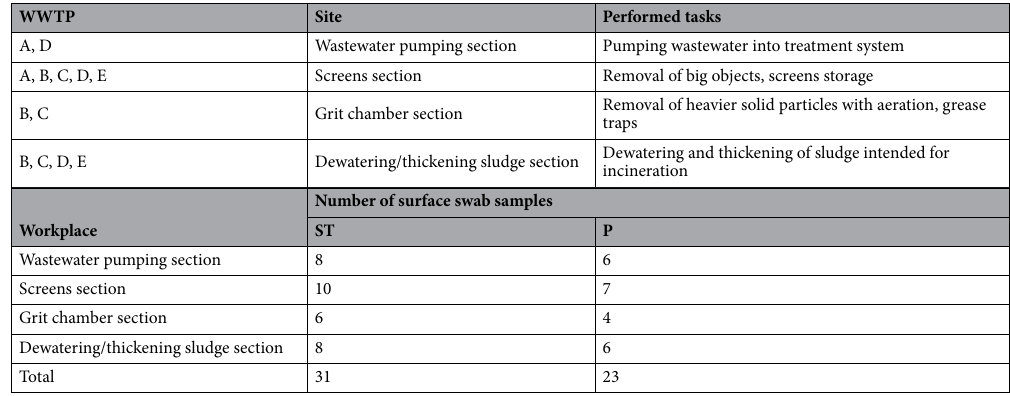
Table 1. Description of studied wastewater treatment plant (WWTP) sites and number and characteristics of surface swab samples. ST steel, P